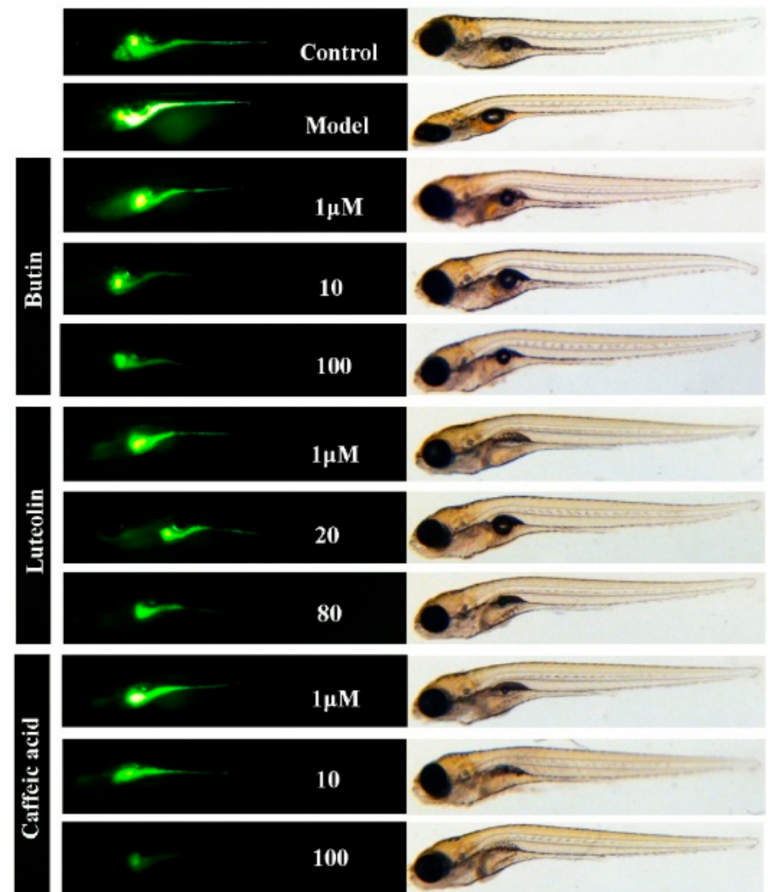
Figure 8. The inhibition of reactive oxygen species effect of compounds in zebrafish. Zebrafishes (5 dpf) were treated with different doses of butin [1, 10, 100] µ M, luteolin [1, 20, 80] µ M and caffeic acid [1, 10, 100] µ M for 24 h and then H2O2 (500 µ M) for 4 h, respectively. DCFH-DA (10 µ M) was added to zebrafish for 30 min, and then images were